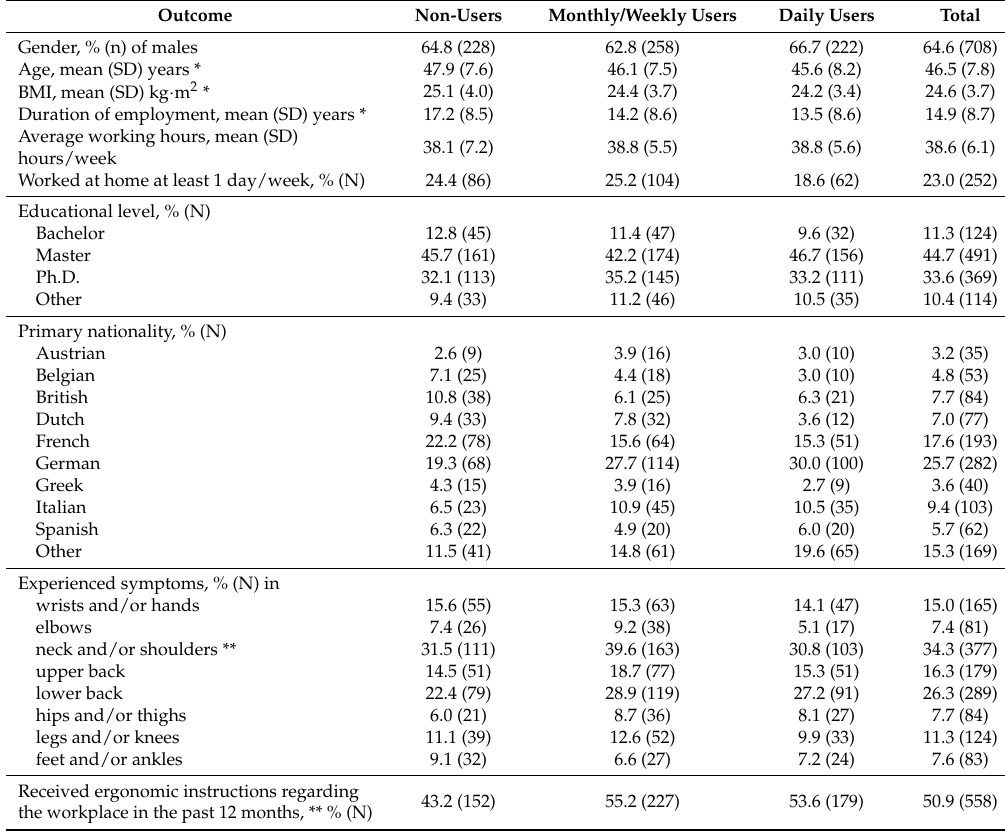
Table 1. Descriptive characteristics of the three user groups and of the total population.